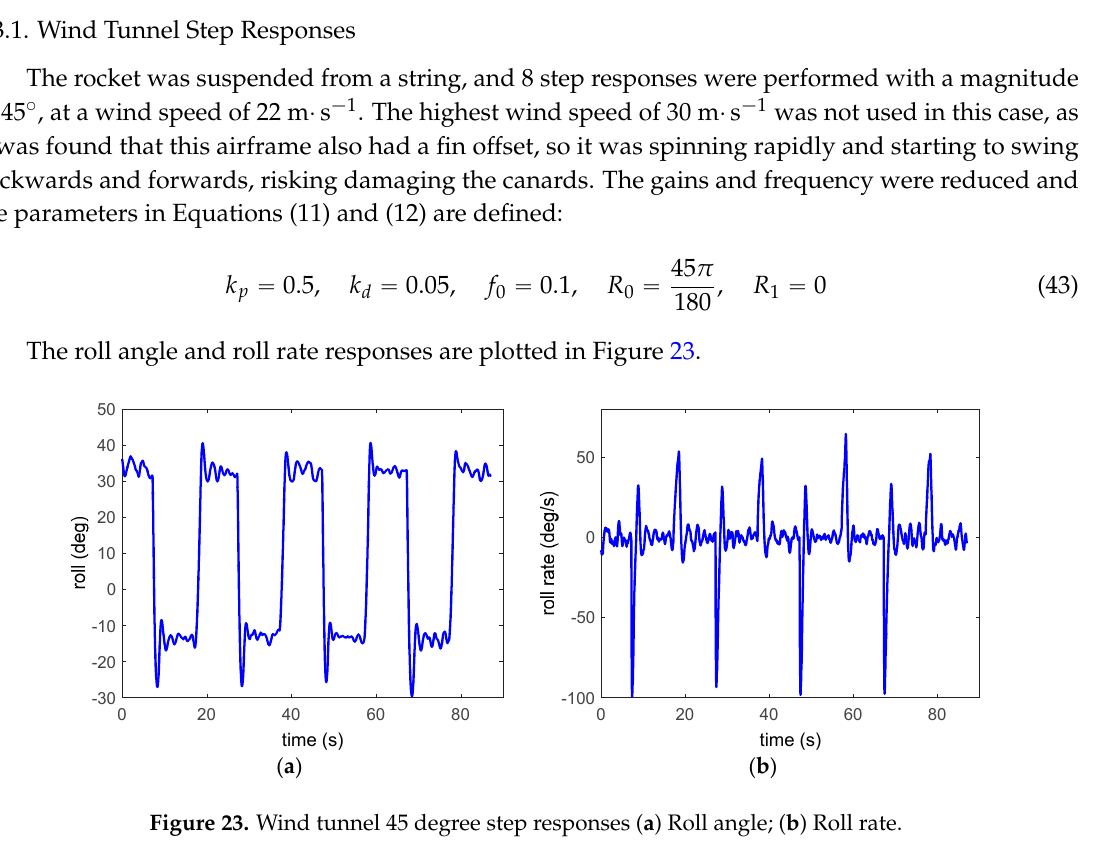
Figure 23. Wind tunnel 45 degree step responses ( a ) Roll angle; ( b ) Roll rate.